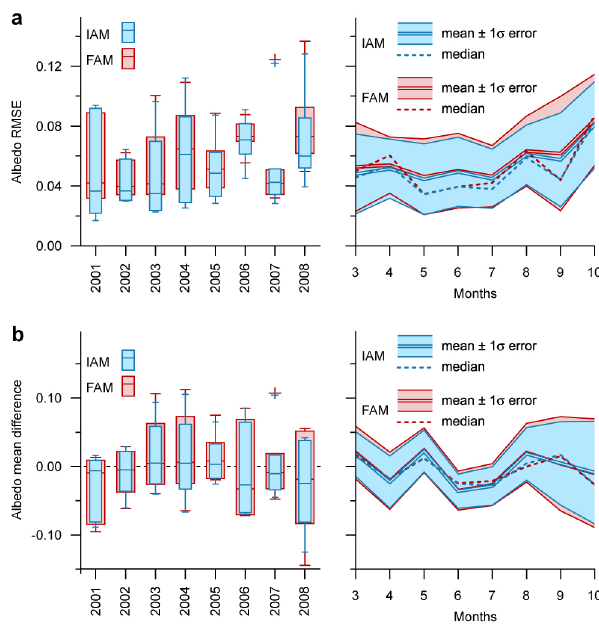
Fig. 4. Mean deviations between MODIS-observed albedo and albedo modelled using the IAM (bluish) and the FAM (reddish). Deviations are expressed as (a) root mean square error (RMSE) and (b) mean difference. The box plots (left) present the annual subdi- vision according to the k-folds cross-validation. The boxes spread between lower and upper quartiles of the sample with the median shown as the line in between, the whiskers extend the boxes by 1.5 times the inter quartile range. Values outside this range (cross sym- bols) are considered as outliers. The line graphs (right) present the temporal evolution of the deviations on the monthly time scale.